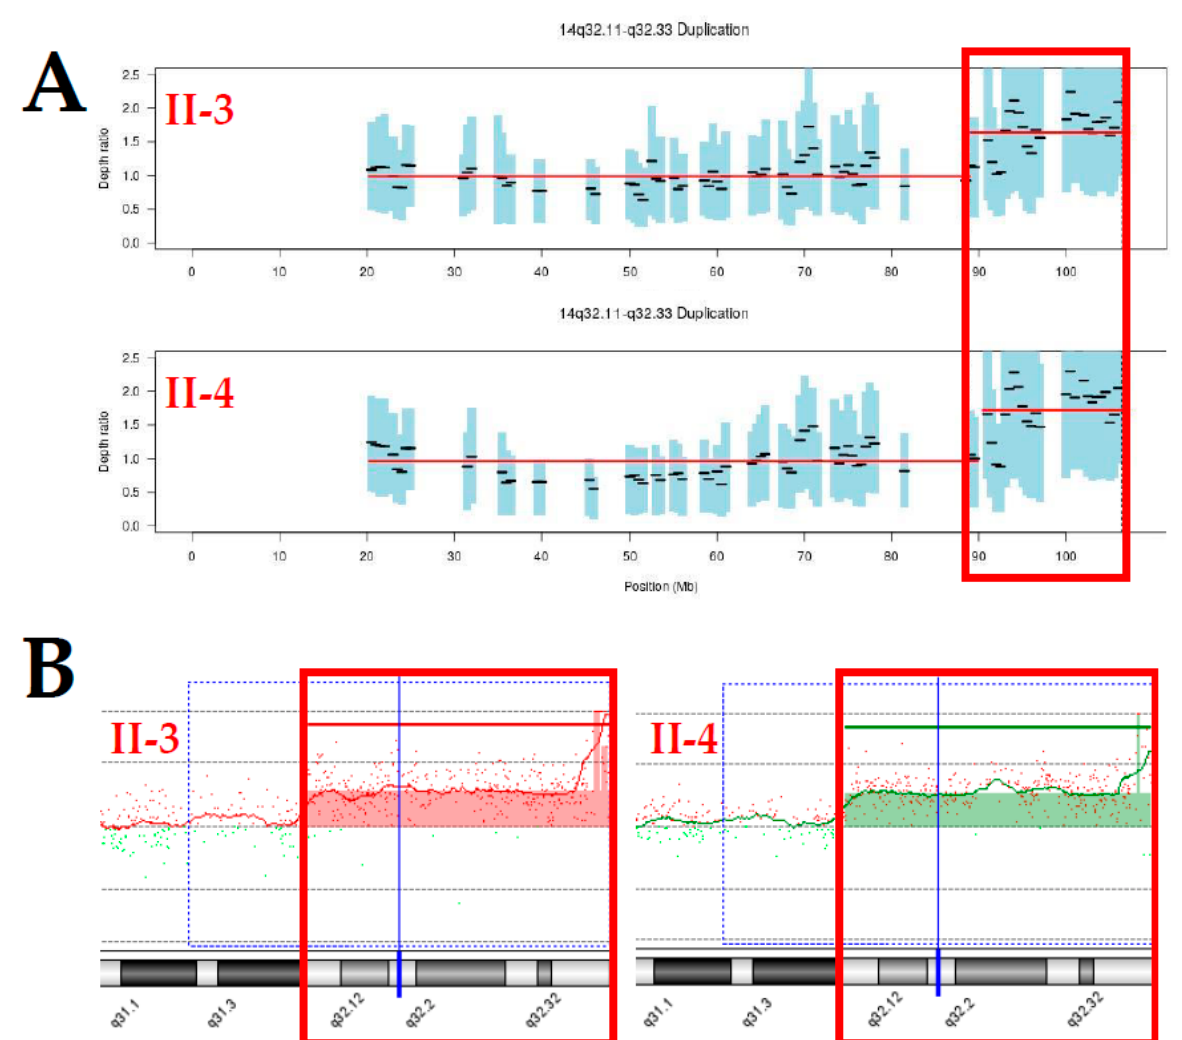
Figure 3. Results of coverage analysis based on duo exome sequencing, and chromosomal microarray in the proband (II-4) and her elder brother (II-3). ( A ) Copy number analysis using duo exome sequencing revealed 14q32.11-q32.33 duplication in the proband (II-4) and her elder brother (II-3), as highlighted in the red box. ( B ) Chromosomal microarray established a gain of 17.2 Mb from 14q32.11 to 14qter in the proband (II-4) and her elder brother (II-3). The arr[hg19]14q32.11q32.33(90,043,558_107,258,824)x3 is highlighted in the red box.